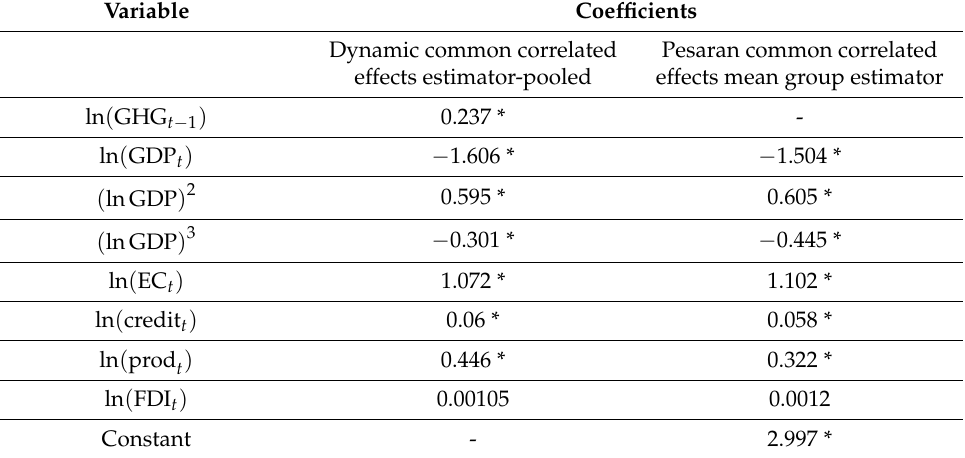
Table 12. Dynamic and Pesaran common correlated effects estimators to explain GHG emissions in